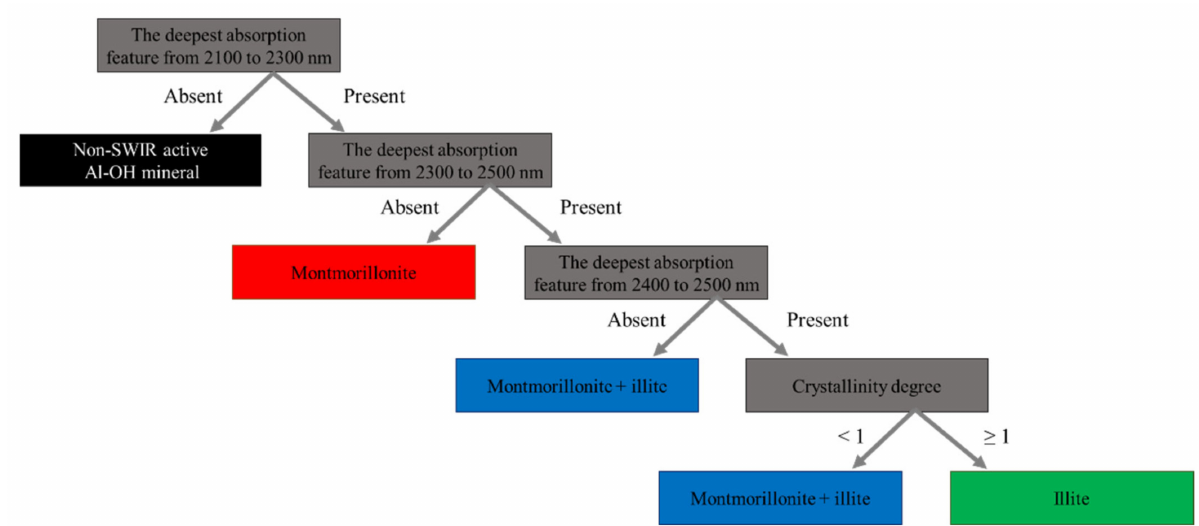
Figure 1. The decision tree for SWIR-active mineral classification. The decision tree was constructed on the basis of the spectral properties of identified minerals within the weathered and freshly cut surface of the rock samples. Montmorillonite + illite indicates a mixture of montmorillonite and illite